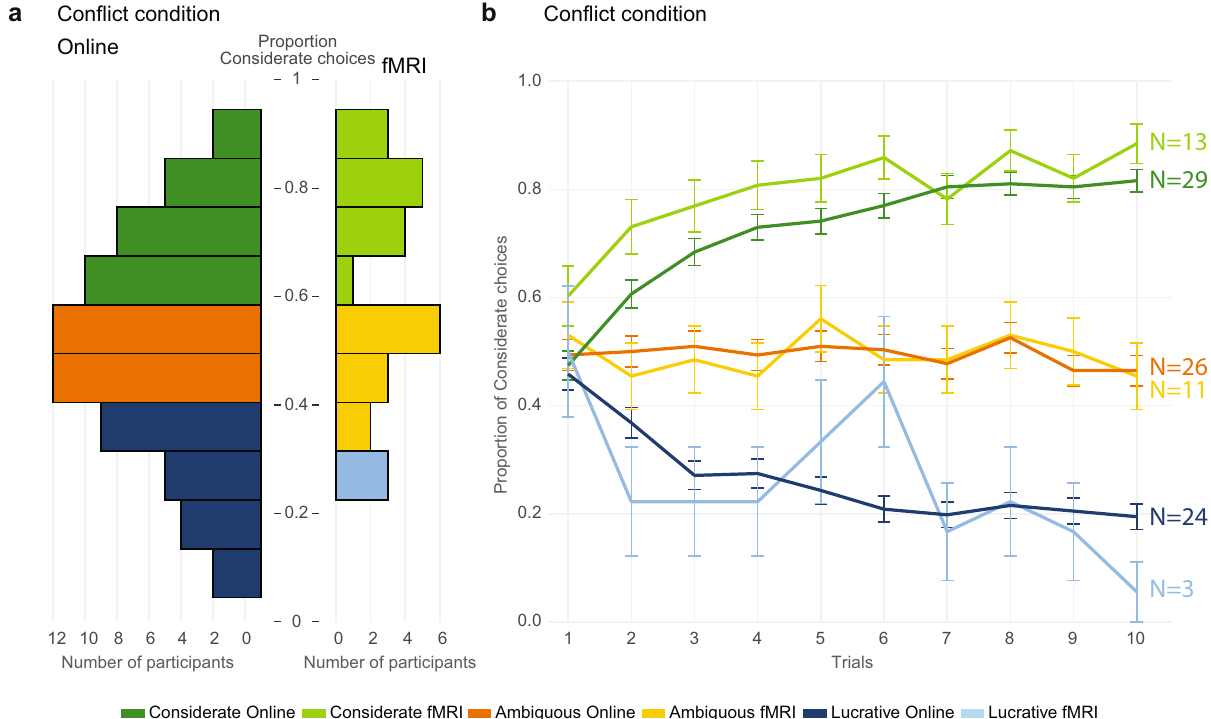
Fig. 2 | Choice allocation in the Con fl ict condition. a Histogram showing the proportion of considerate choices per participant over the fi rst 10 trials of all available blocks of the Online (12 blocks of 10 trials: 4 blocks×10 trials from the Con fl ictNoDropout; 4 blocks×10 trials from the Con fl ictMoneyDropout, and 4 blocks×10 trials from the Con fl ictShockDropout conditions) and fMRI (6 blocks×10 trials of the Con fl ictNoDropout condition) experiment. Participants with above chance proportion of choices (Considerate preference) are shown in dark (Online) or light (fMRI) green; participant with below chance (Lucrative pre- ference) are shown in dark (Online) or light (fMRI) blue, and participants within